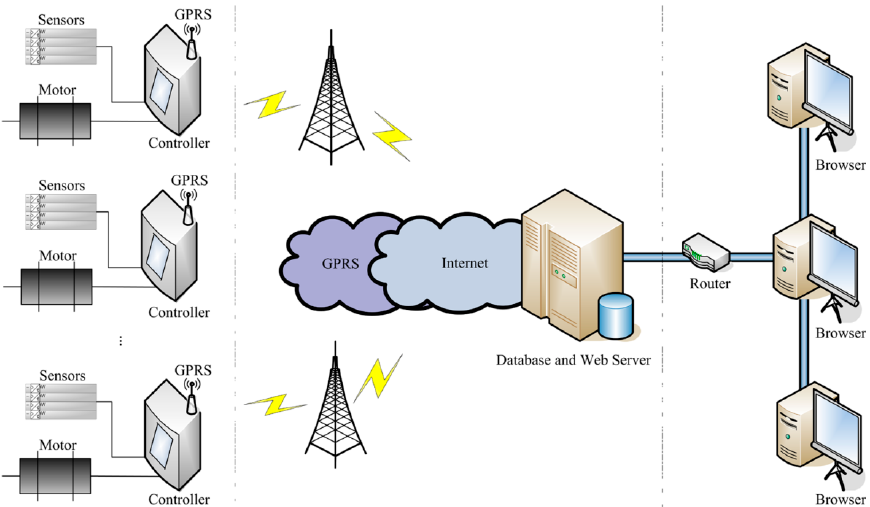
Figure 1. Overall architecture diagram of the energy saving system.